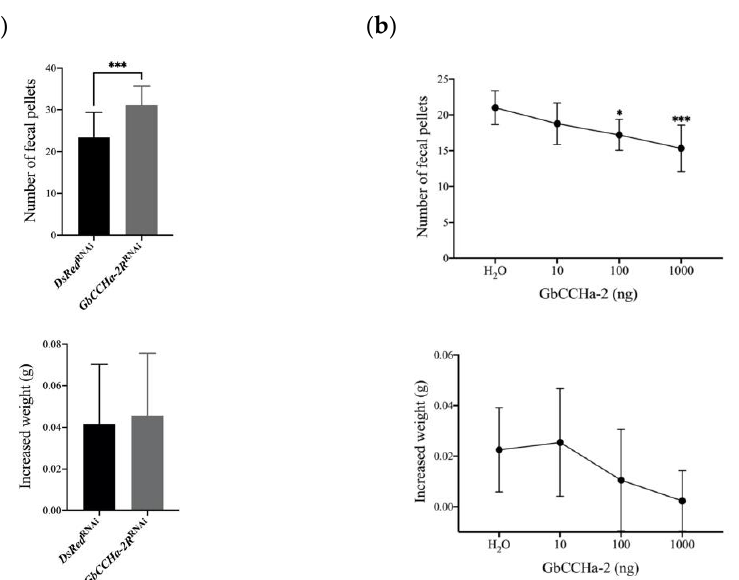
Figure 2. RNAi efficiency. The relative mRNA levels of GbCCHa-2R in CNS ( a ) and gut ( b ) on the third day after dsRNA injection. ß-actin was used as the reference gene. Values are shown as mean + S.D., n = 5 – 9, * p < 0.05, ** p < 0.01, unpaired t -test.